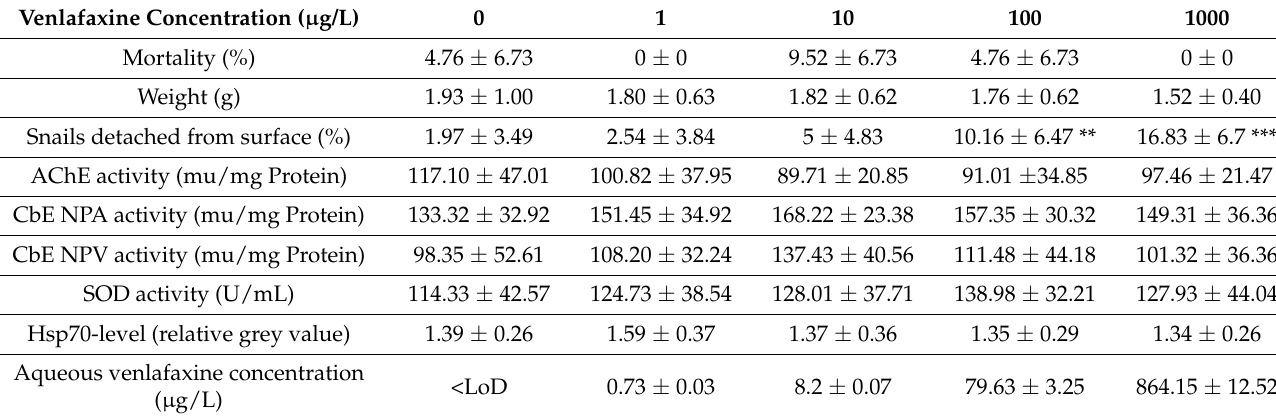
Table 2. Results obtained in the experiment with